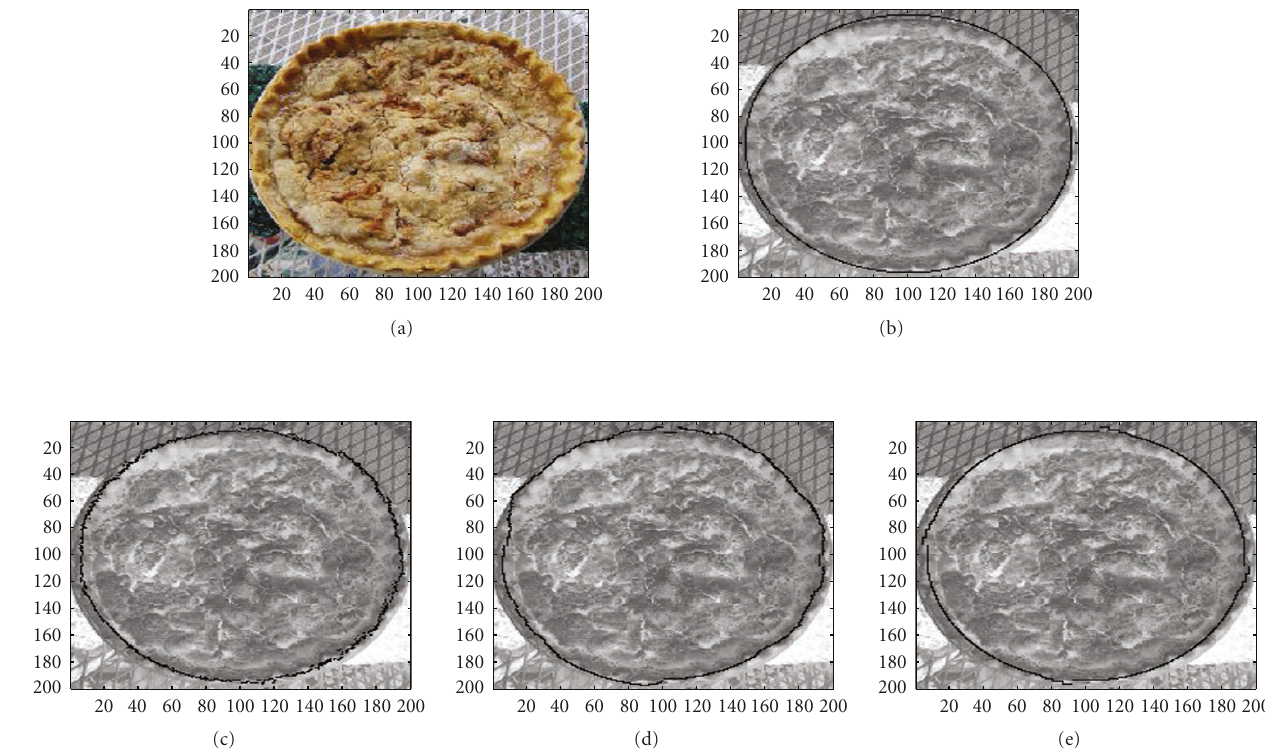
Figure 12: (a) Processed image. (b) Initialization. (c) Result obtained with gradient method. (d) Result obtained with GVF. (e) Result obtained with DIRECT combined with spline